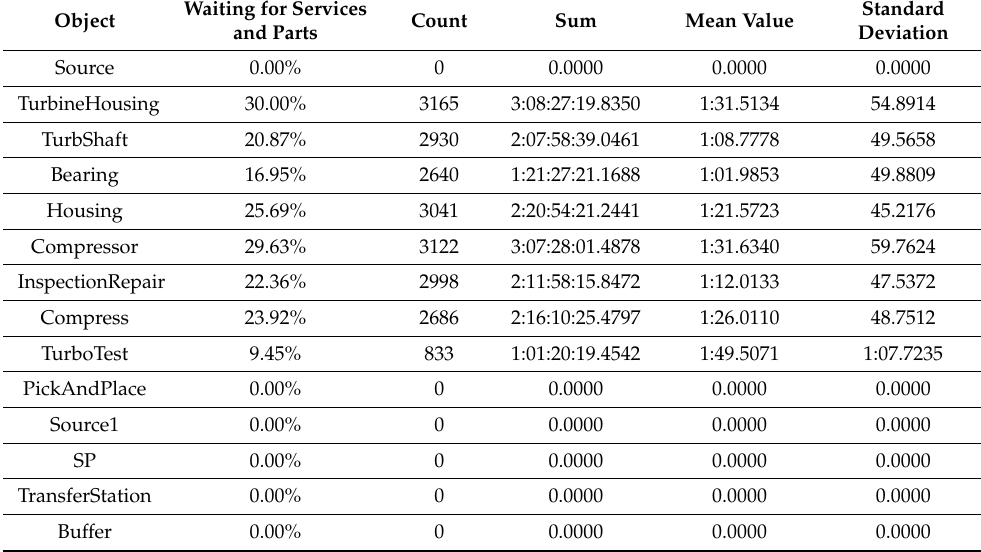
Table 1. Online data operation of chosen processes used by virtual reality